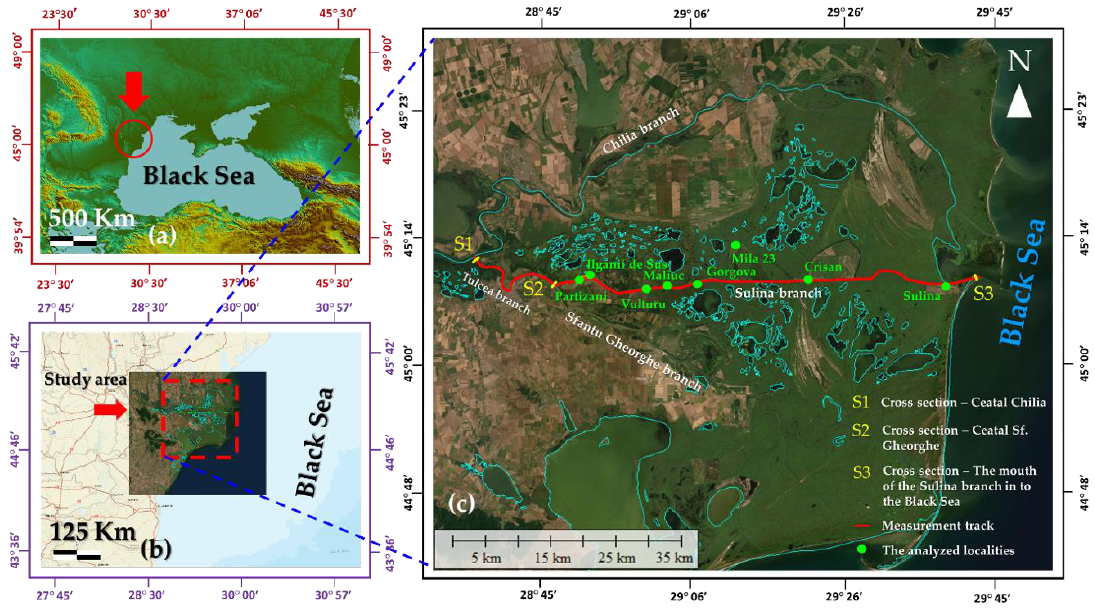
Figure 1. Geographical locations of the settlements along the Sulina branch considered for this study, ( a ) the study area superimposed on the topographic map; ( b ) the geographical position of the settlements superimposed on the ortho-photomaps of the Danube Delta (the green dots are the settlements located along the Sulina branch) and the patch on which topo-bathymetric measurements were performed (S1, S2 describe the cross sections measured in the first part of the river, and S3 describes the cross section measured in the river’s second part); ( c ) the study area superimposed on the digital terrain model.